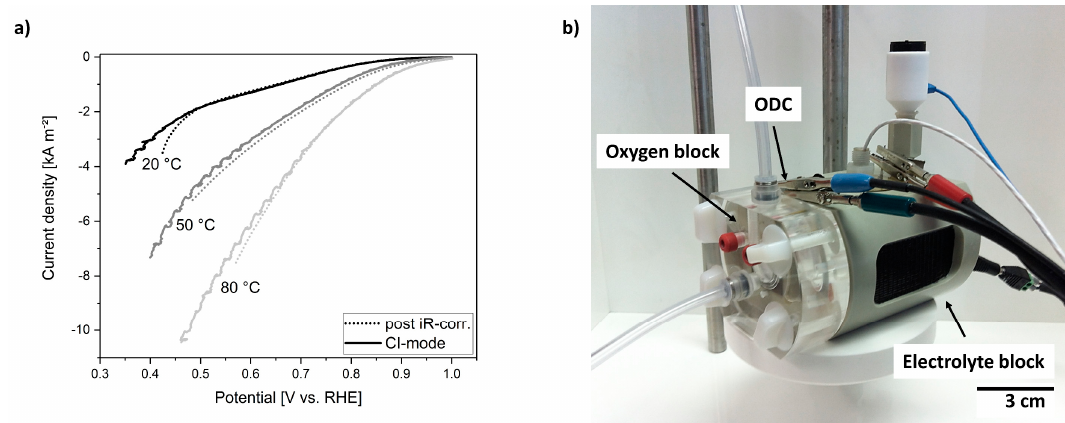
Figure 4. ( a ) Linear sweep voltammograms (LSV) of technical ODC in Gaskatel cell (20, 50, and 80 °C, 30 wt.% NaOH, correction of applied potential by post-correction (dotted lines) or CI-mode (full lines), sweep rate 2 mV s − 1 ); ( b ) photography of operating Gaskatel cell.